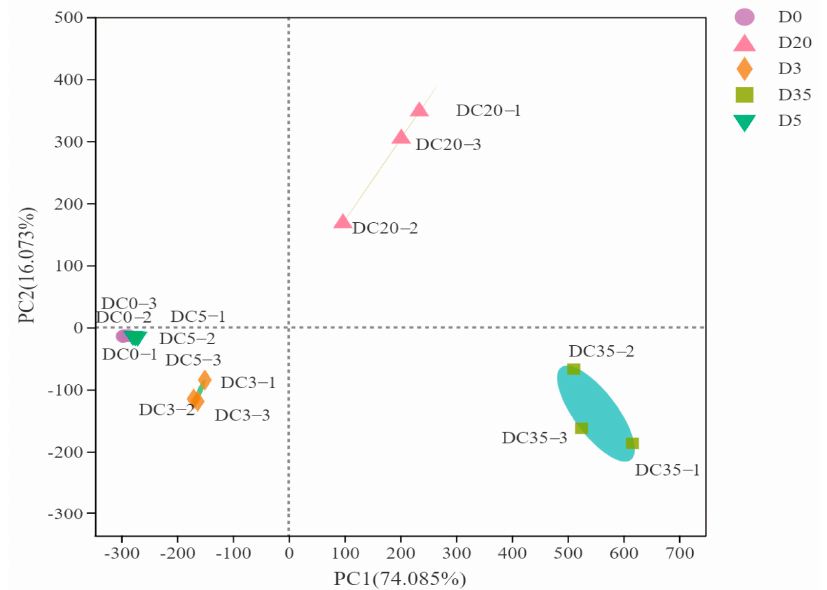
Figure 6. PCA plot of Douchi samples at different fermentation stages. The numbers 1, 2, and 3 represent three parallel